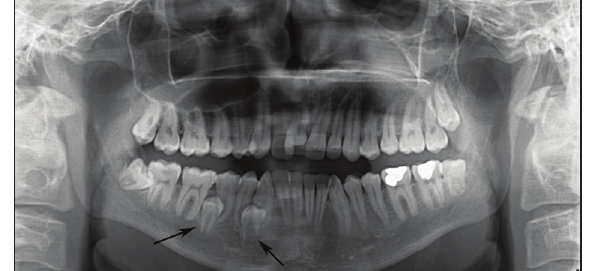
Figure 2. Panoramic radiograph of patient aged 33 years (case 18). This patient complained of pain that was due to supernumerary premolars in the lower right premolar region (arrows).